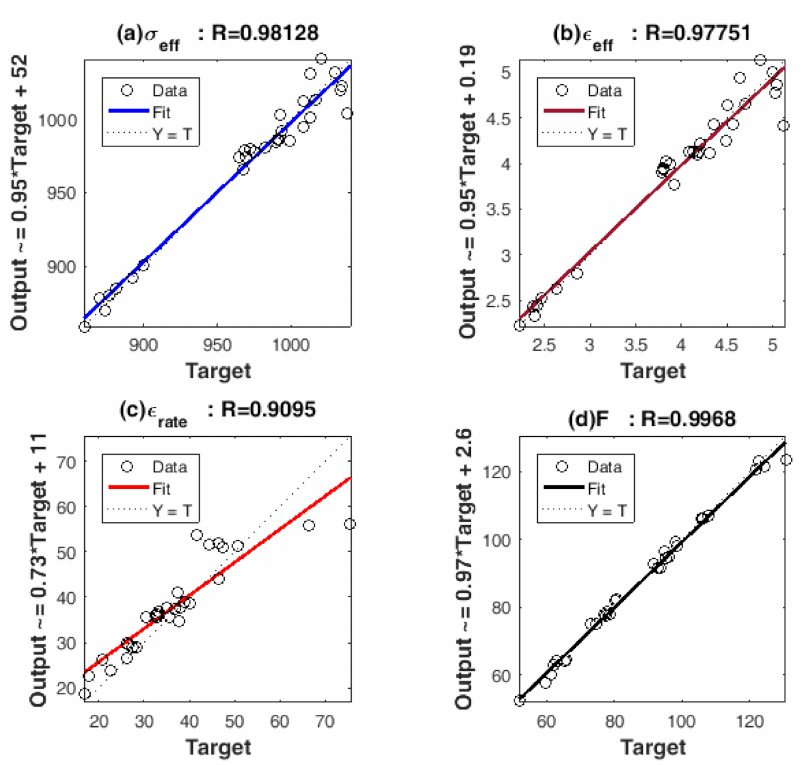
Figure 6. Post-regression analysis with 30 testing patterns for: ( a ) E ff ective stress; ( b ) E ff ective strain; ( c ) E ff ective strain rate; and ( d ) Punch